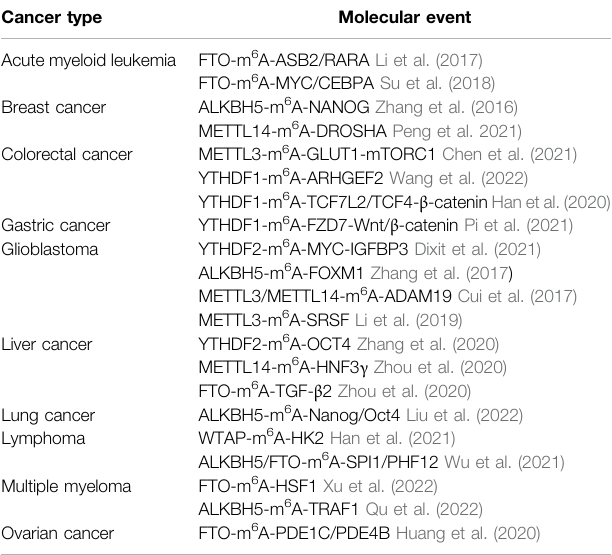
TABLE 1 | M 6 A-mediated molecular events in different cancer types. Cancer type Molecular